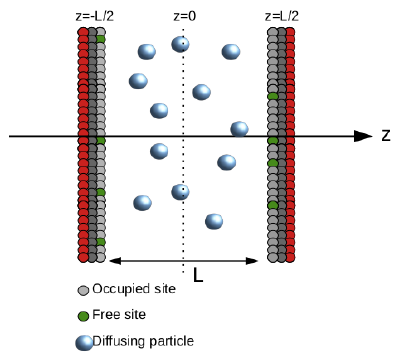
Figure 1. System studied in this work. It consists of a liquid with diluted neutral particles (diffusing particles) that diffuse in the z − direction and may be adsorbed (desorbed) following Langmuir’s equation. Notice that the left surface is located at z = − L /2, while the right surface is at Z = L /2. Gray spheres represent occupied sites on the surfaces, while green spheres represent free adsorption